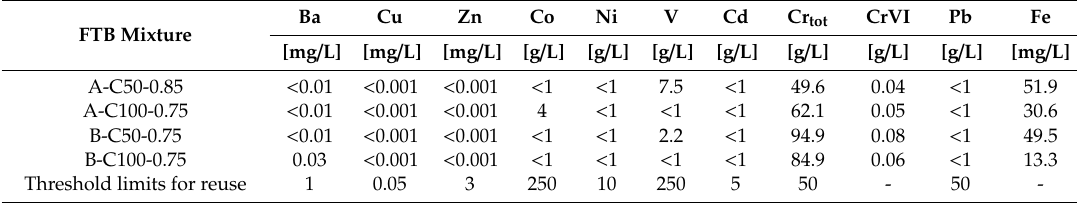
Table 10. Results of leaching tests performed on FTB mixtures (threshold limits defined in [43]). FTB